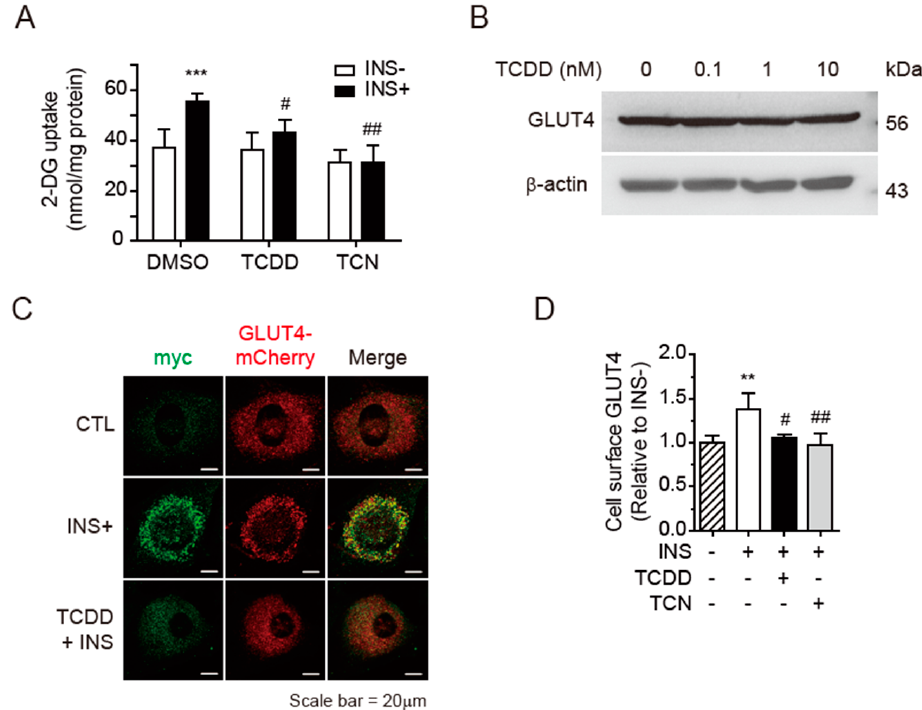
Figure 1. TCDD suppressed the insulin-stimulated glucose uptake and GLUT4 translocation. C2C12 myoblasts were treated with DMSO, 100 pM of TCDD, or 2 µ M of triciribine (TCN) for 48 h and stimulated with 100 nM of insulin (INS+) for 10 min. ( A ) Glucose uptake. The reagent-treated cells were incubated with 1 mM of 2-deoxyglucose (2-DG) for 30 min. The amounts of 2-DG transported into the cells were measured via enzymatic assay for 2-DG uptake. ( B ) Western blot. TCDD-treated C2C12 cell lysates were separated on 10% SDS-PAGE and detected with GLUT4 antibody, with β -actin as the loading control. ( C ) Representative confocal image of the subcellular colocalization of myc (green) with GLUT4-mCherry (red). The C2C12 cells expressing myc-GLUT4-mCherry were incubated with DMSO or 100 pM of TCDD for 48 h with or without stimulation with insulin (INS+). The cells were fixed and incubated with mouse anti-myc antibody and Alexa Fluor 488-conjugated secondary antibody under non-permeabilized conditions. Confocal images were obtained at 488 or 555 nm for myc or GLUT4-mCherry, respectively. Scale bar = 20 µ m. ( D ) Colorimetric quantification of cell surface myc (GLUT4) using o -phenylenediamine dihydrochloride reagent. Data are presented as means ± SEM ( n = 4~6). Note: ** p < 0.01, *** p < 0.001 vs. INS- control; # p < 0.05, ## p < 0.01 vs. INS+